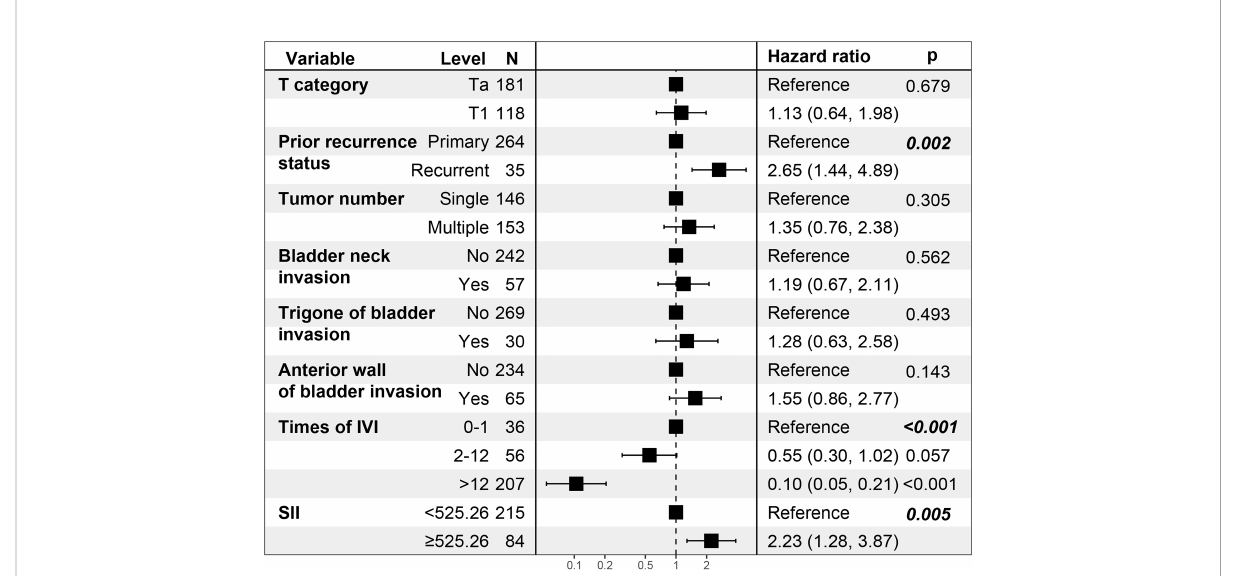
FIGURE 3 Multivariate Cox regression analysis of the patients ’ clinicopathologic features. N, number of patients; IVI, intravesical instillation; SII, systemic immune-in fl ammation index = platelet*